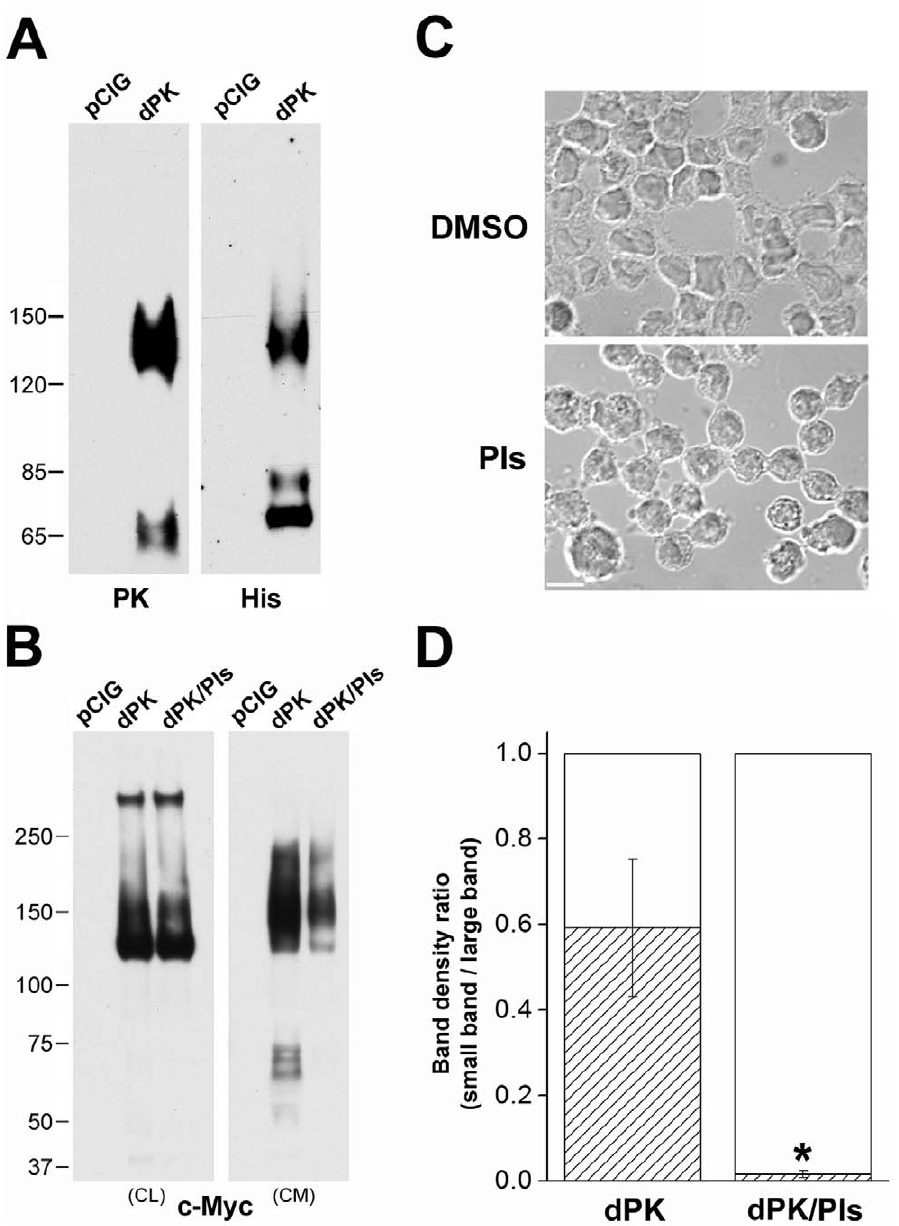
medium for control cells. Bar=10 m m. (D) Density ratios of Western blot bands (N-fragments/monomers, Fig. 4B). N=3 experiments. *=significant difference between protease inhibition treatment group (dPK/PIs) and control group (dPK) (p , 0.05, one-way ANOVA